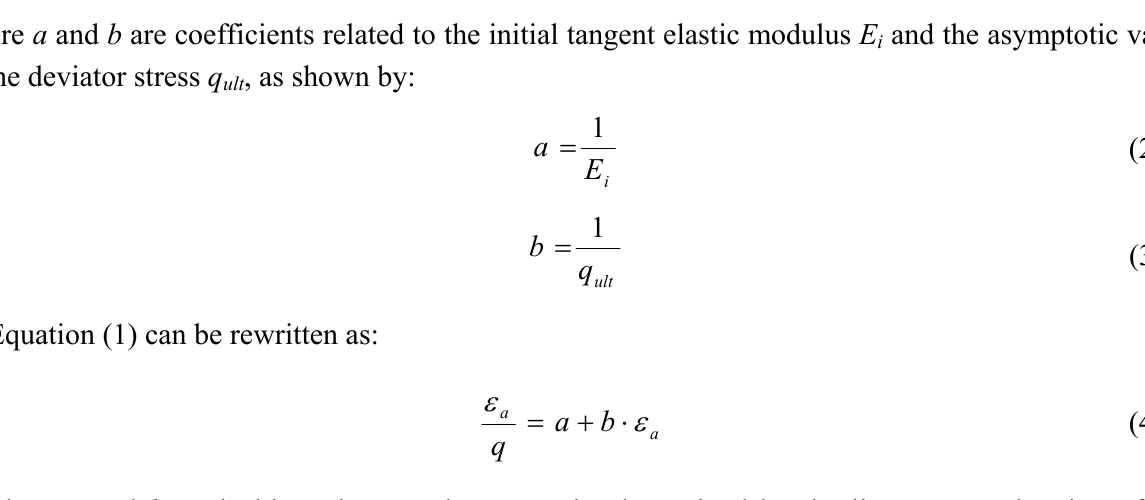
versus methane hydrate saturation S f